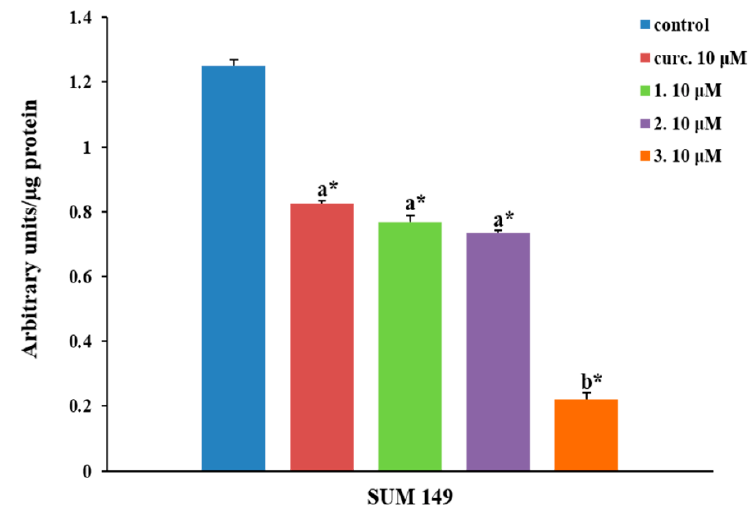
Figure 6. NF- κ B (p65 subunit) DNA binding capacity in nuclear extracts of SUM 149 cells. The cells were treated for 24 h with curcumin and derivatives 1 – 3 . Results (mean ± standard error of two experiments carried out in duplicate) are expressed as arbitrary units/ μ g protein of cells nuclear extracts. Different letters (a and b) in the column of the cell lines and treatments represent significant differences among the different treatments. * Differences when treatments are compared to the control, p < 0.01.